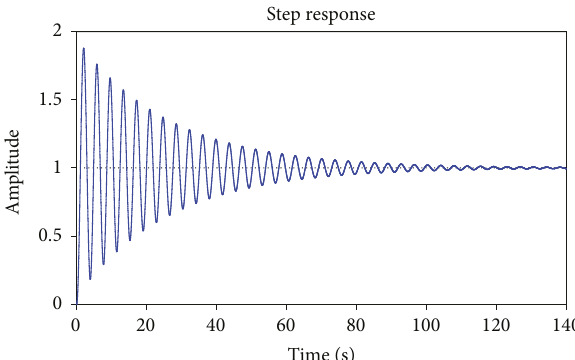
Figure 6: Step response of the stable system.